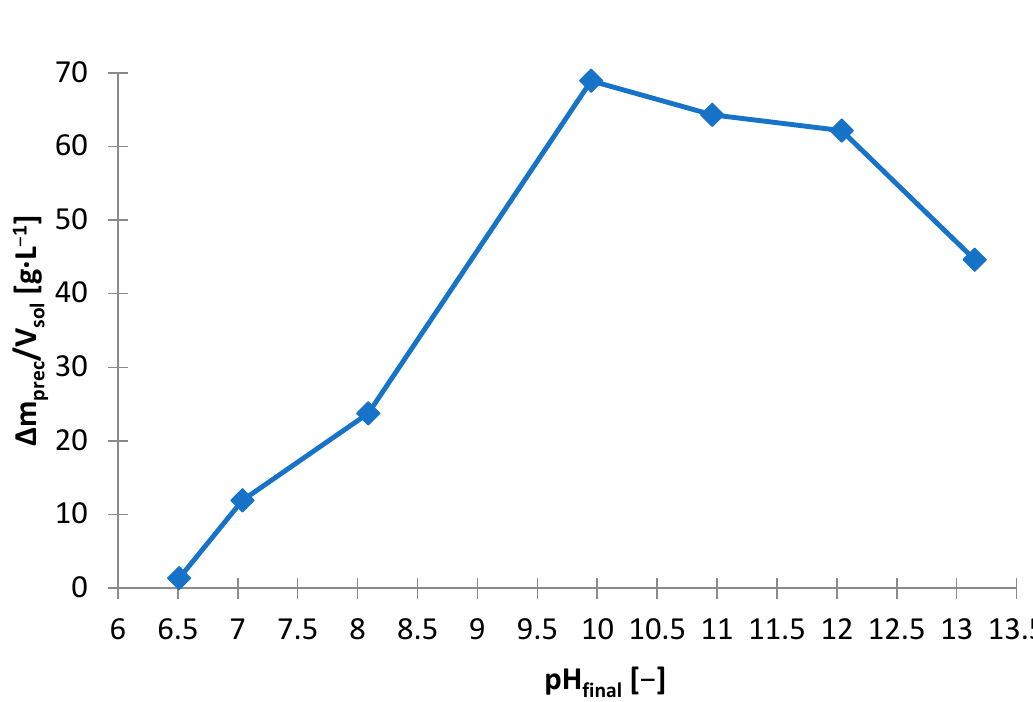
Figure 17. Effect of on final pH (pH final ) on amount of precipitate ( ∆ m prec /V sol ) during precipitation by using NaOH from solution after non-selective leaching. The freshly precipitated solids turned violet-brown in color and turned black on exposure to air, which indicated that they contained manganese hydroxide. As the pH increased, the concentration of manganese increased (from 8.5 to 66 wt.%) and the con- centration of zinc decreased (from 82 to 20 wt.%) (see also Figures 18 and 19). High sulfur concentration in the range of pH = 10–12 was caused by the co-precipitation of sodium sulphate, which resulted from the increasing sulfur content, reaching approx. 27 wt.% SO 3 . The precipitate obtained at pH = 13 contained considerable amounts of both man- ganese and zinc, approx. 66 and 20 wt.%. Such material requires further treatment, e.g., by selectively leaching zinc without leaching the manganese. It is not quite a selective method; moreover, it requires the use of 130 g of NaOH per liter of solution.